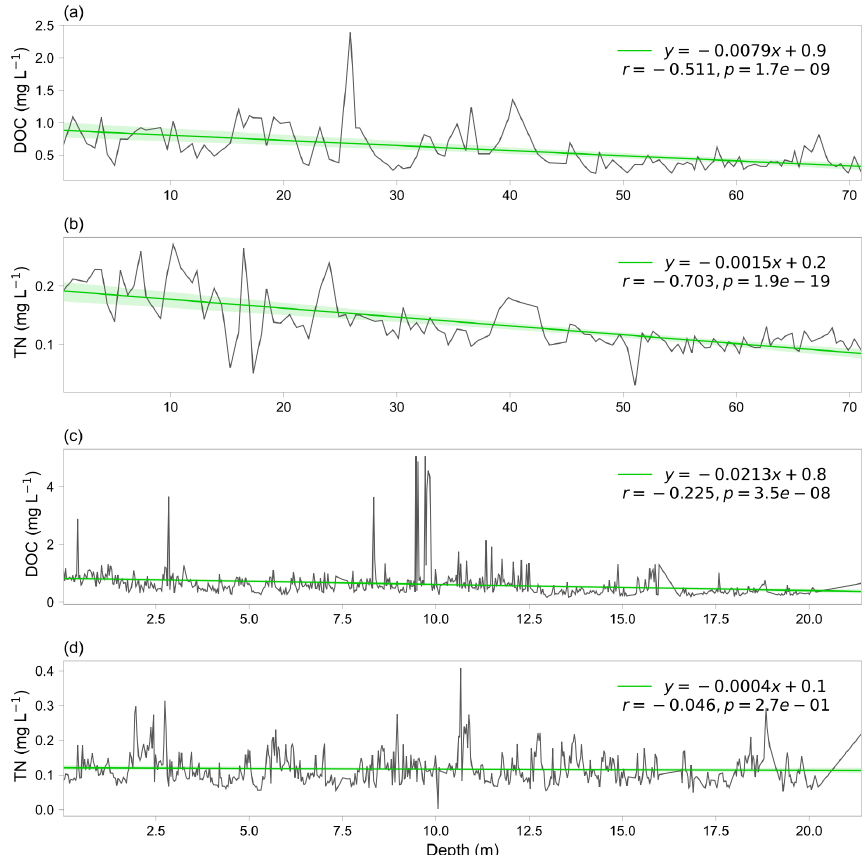
Figure 6. Variation of DOC (a, c) and TN (b, d) concentrations along vertical profiles in ice cores of the MSTG (Muztagh Ata) glacier (a, b) and the ERB (East Rongbuk) glacier (c, d) .